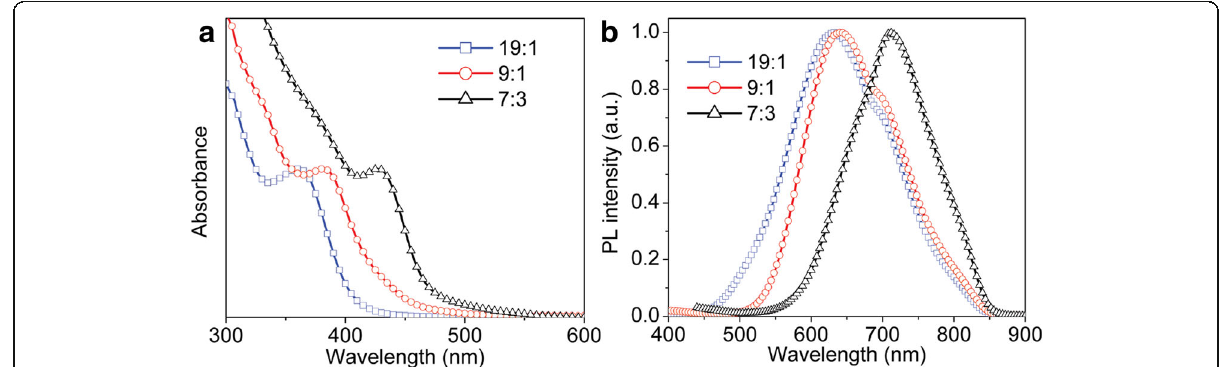
Fig. 8 a Absorption. b PL spectra of CdS:Cu(I) NCs with different Cu doping levels, and the excitation wavelength is 350